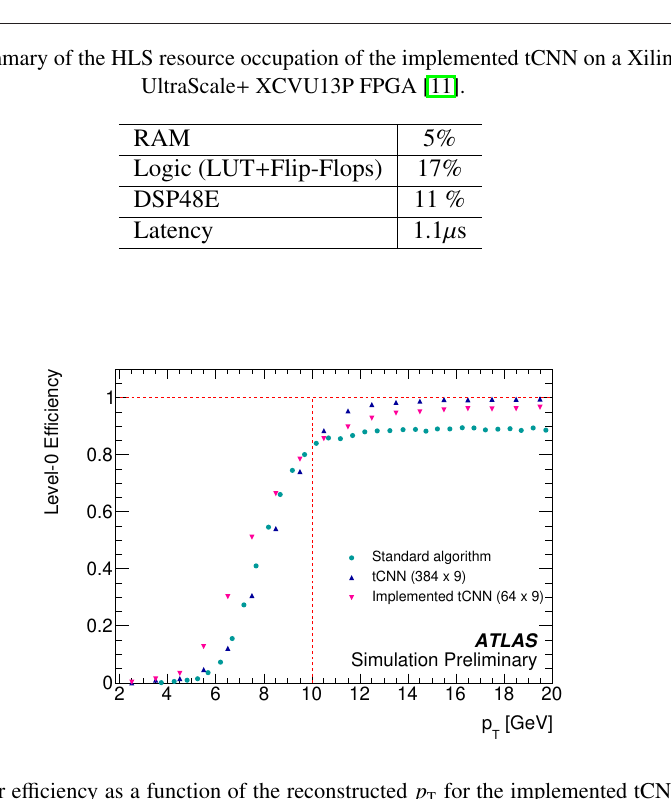
Figure 6. Trigger e ffi ciency as a function of the reconstructed p T for the implemented tCNN in com- parison with the optimal tCNN and the Standard Algorithm